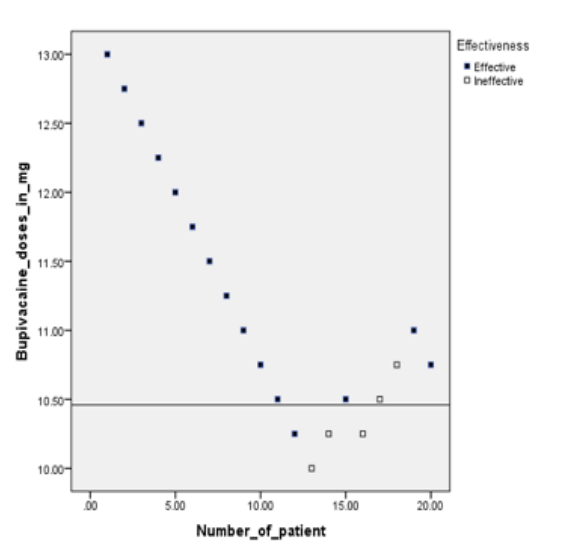
Figure 1. The MLAD of bupivacaine for cesarean section was 10.459 mg (CI 95%: 10.12–10.87)), using the formula of Dixon and